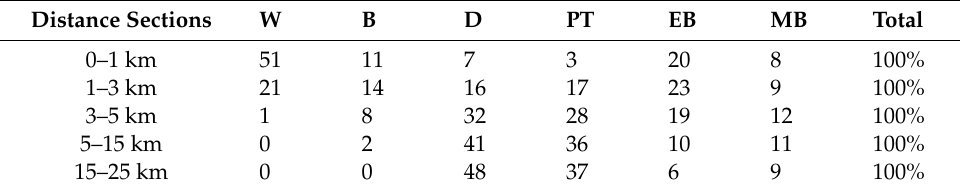
Table 1. Travel-mode choice survey results, based on distance